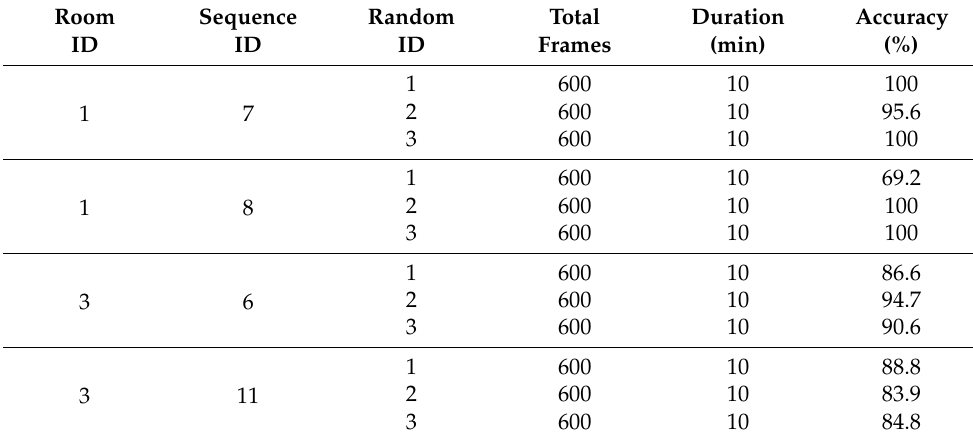
Table 5. Accuracy for the randomly generated testing sequences.